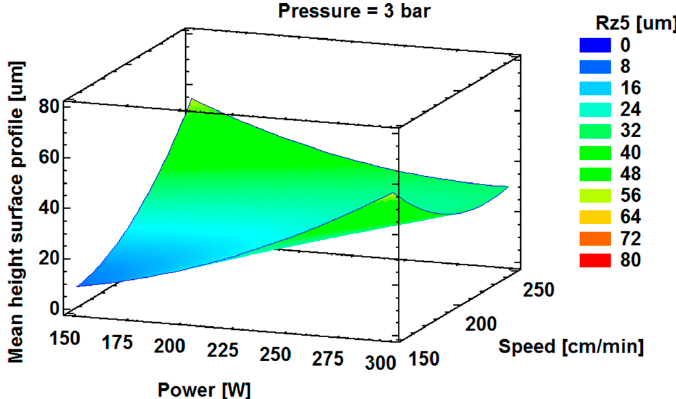
Figure 9. Response surface plot for the effects of the cutting parameters on mean height of the surface profile (R Z 5). Oxygen pressure 3 bar.